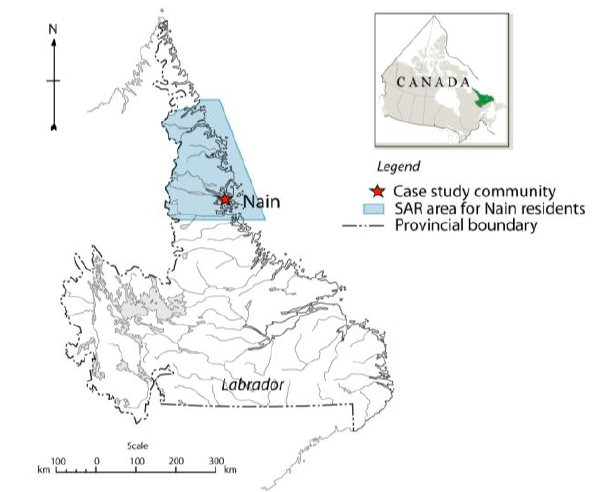
Figure 1. Location of Nain in Labrador, Canada, and the maximum SAR area for Nain residents [31].